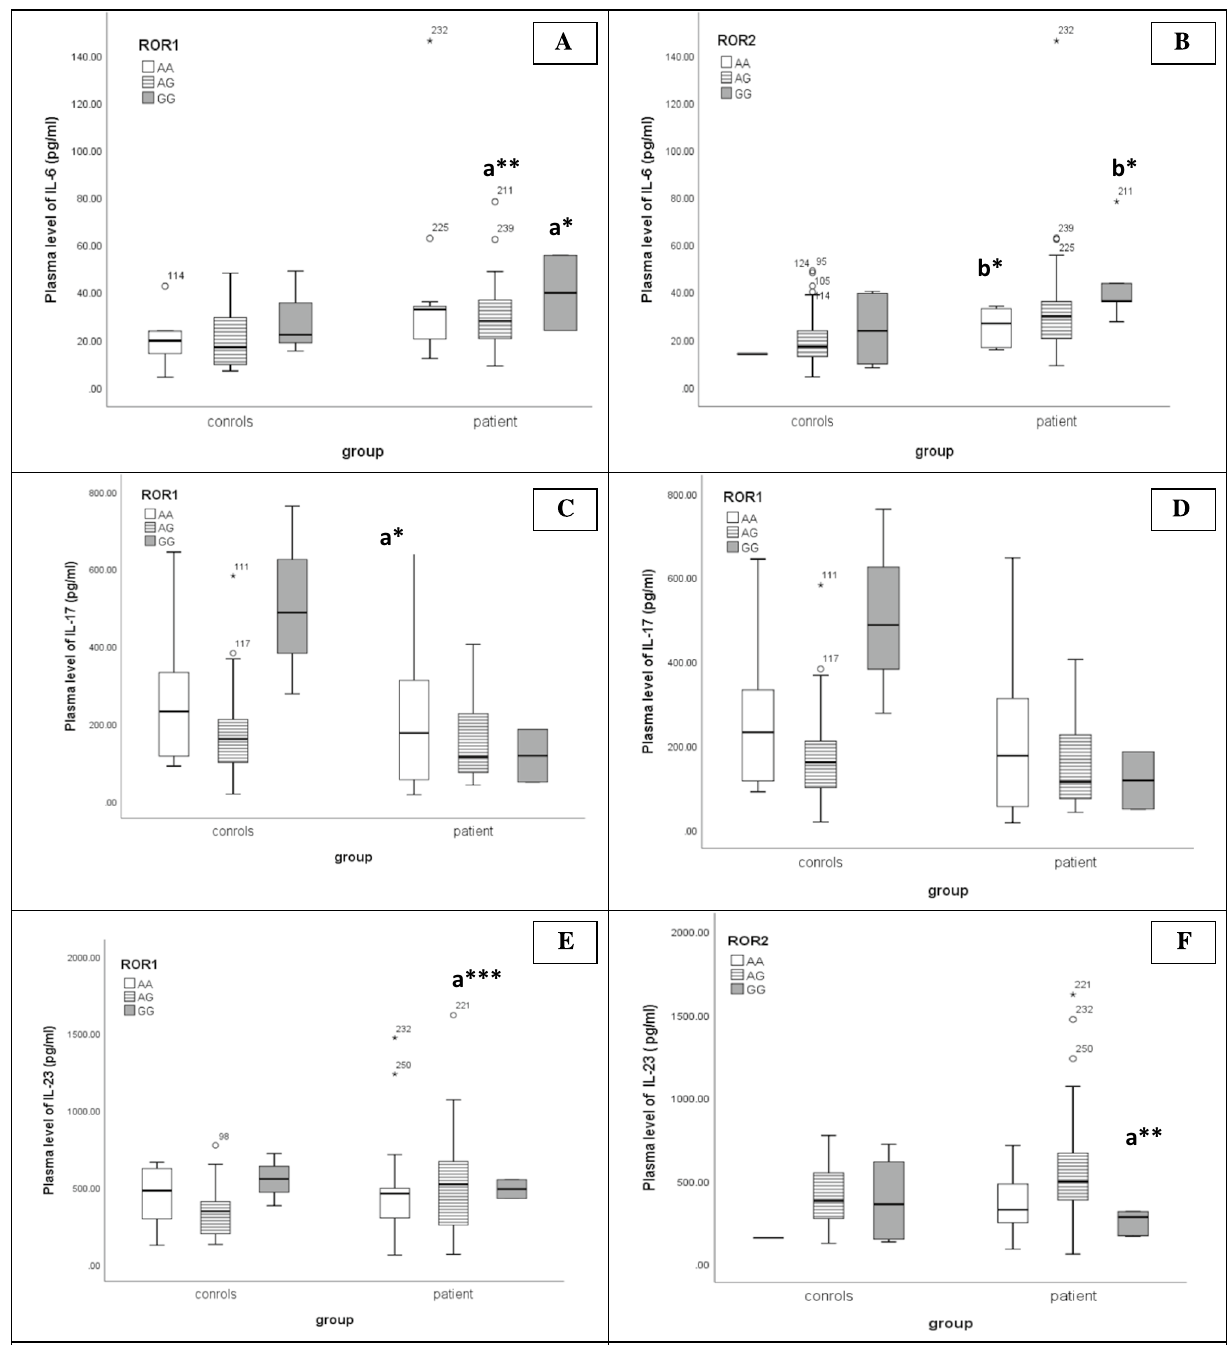
Fig. 4 Association between ROR-γ [rs9017A/G ( A , C , E ) and rs9826A/G ( B , D , F )] SNPs and Th17 related cytokine (IL-6, IL-17&IL-23; respec- tively) in controls and patients. Line inside the box representing Median, Boxes representing 25th and 75th percentiles and the lines outside the boxes indicating 10th and 90th percentile. a: relative to control; a: relative to control [*p < 0.05/NS, **p < 0.01/p < 0.05, ***p < 0.001/p < 0.01], b:relative to control [*p < 0.05/p < 0.05],